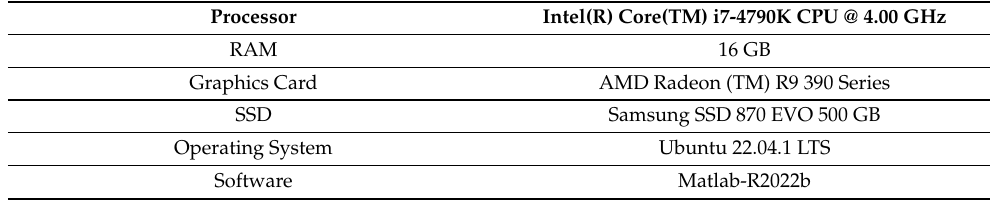
Table 3. Personal computer specifications.